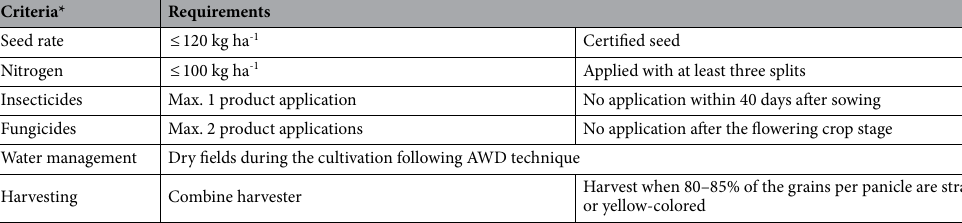
Table 2. Specifications of best practices for irrigated rice production (1 Must (certified seed) and 5 Reductions (reduced rates of seed, fertilizer, pesticides and water; reduced post-harvest losses) applied in the field trial at Trung-Thanh Village, Co Do District, Can Tho, for both seasons. (Max. = maximum). *Postharvest processes were excluded for analyses of the findings in this